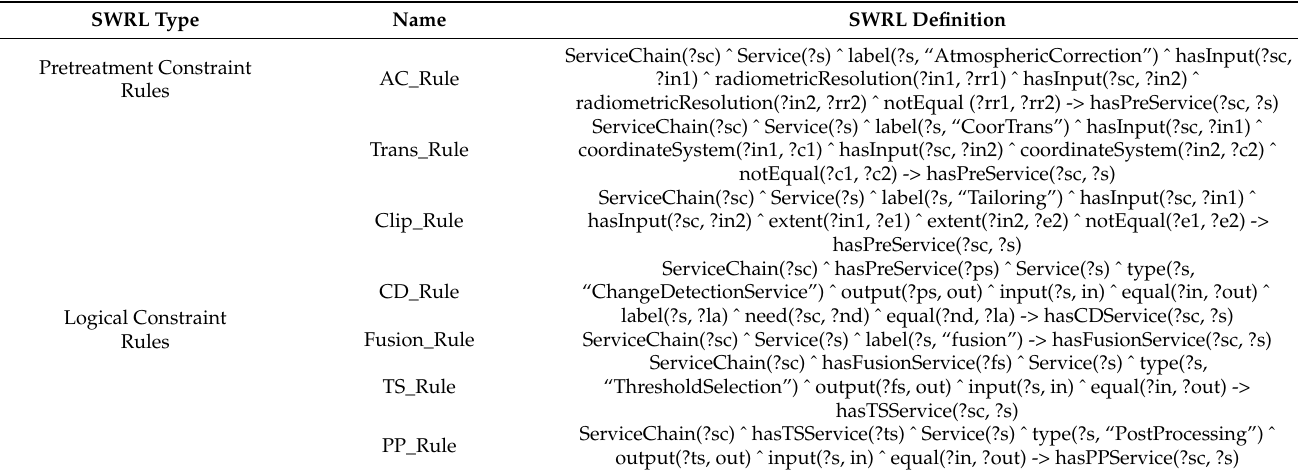
Table 3. A detailed list of defining logical process constraint